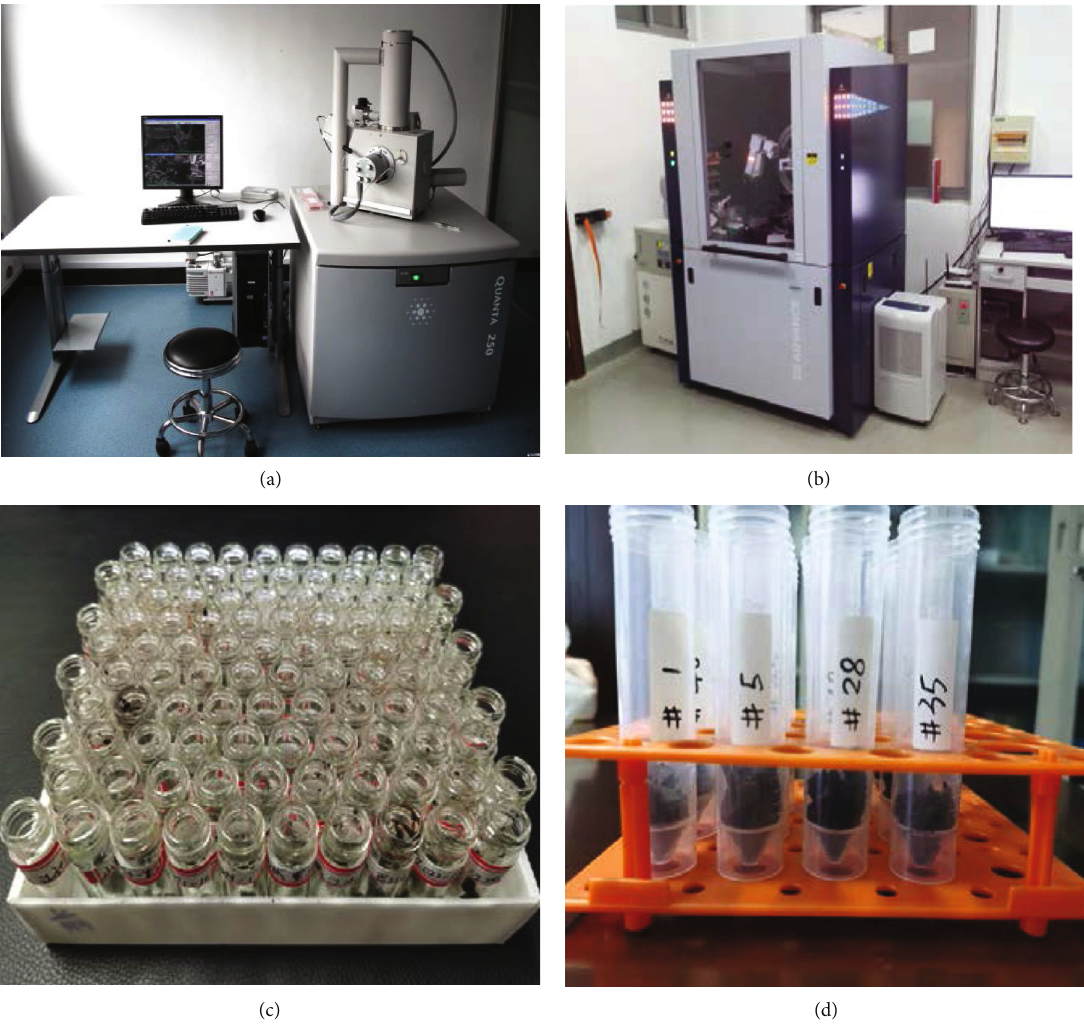
Figure 4: Composition analysis for scale samples: (a) energy dispersive spectroscopy (EDS); (b) X-ray di ff raction (XRD); (c) scale sample preparation for EDS; (d) scale sample preparation for